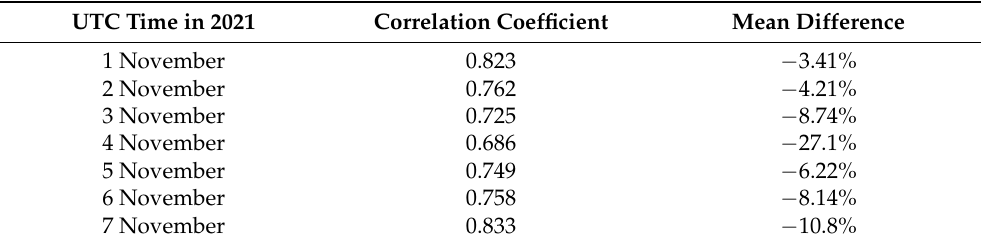
Table 1. Comparison between the POD-derived densities and NRLMSISE-00 densities. UTC Time in 2021 Correlation Coefficient Mean